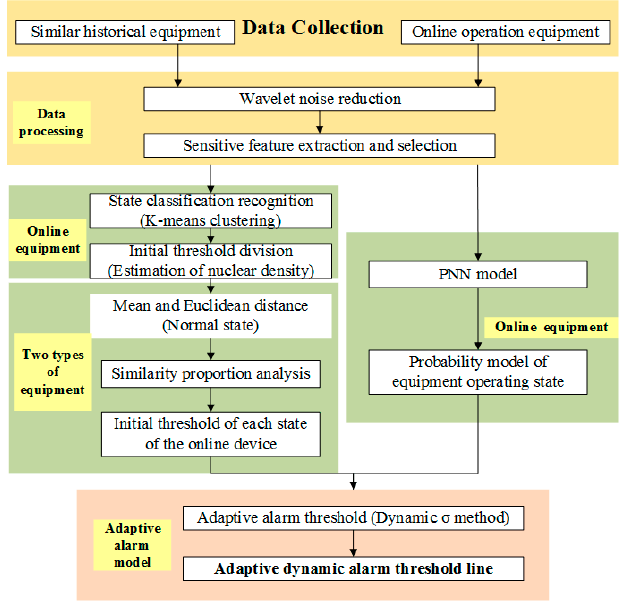
Figure 1. The flowchart of method.